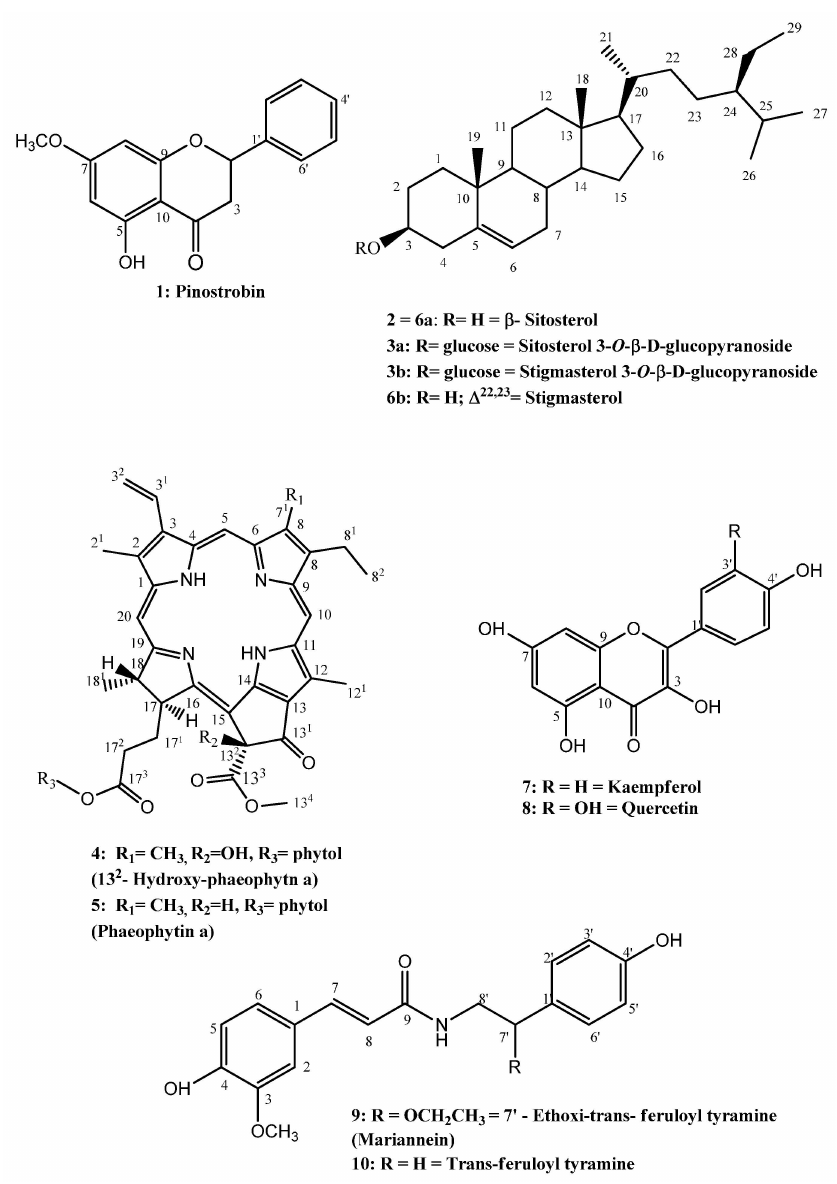
Figure 1. Compounds isolated from Pilosocereus gounellei